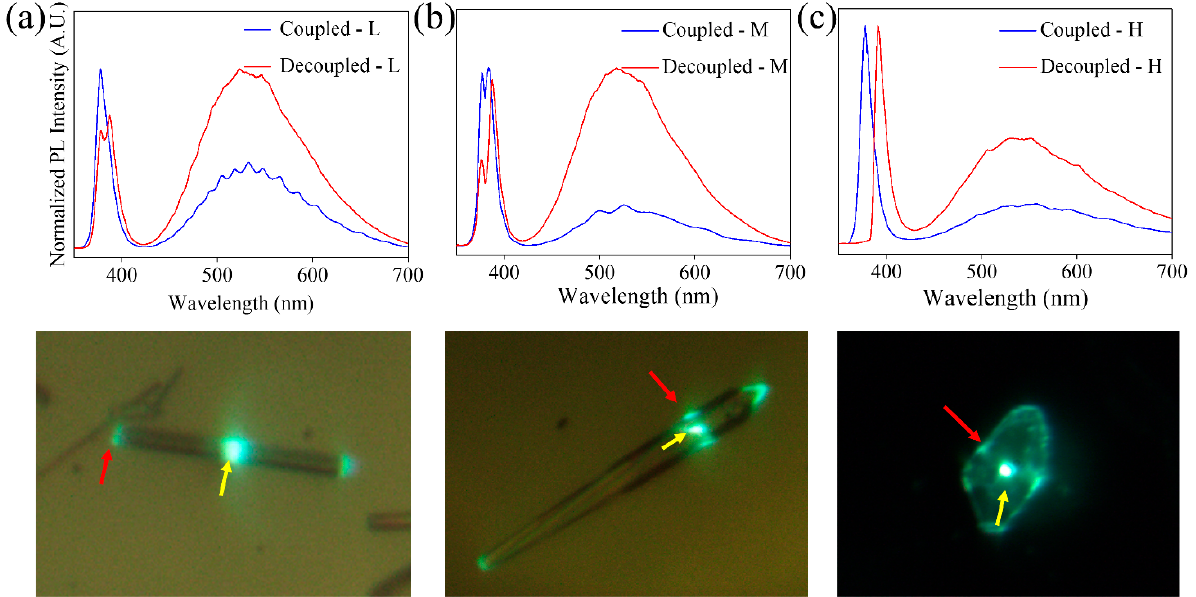
Figure 11. Analysis by photoluminescence spectra of light guidance on ( a ) L, ( b ) M and ( c ) H. Below each of the spectra, the optical image of the structure where the measurements were made is shown. The yellow arrows indicate the excitation point, while the red arrows indicate where the light is collected for the decoupled spectra.